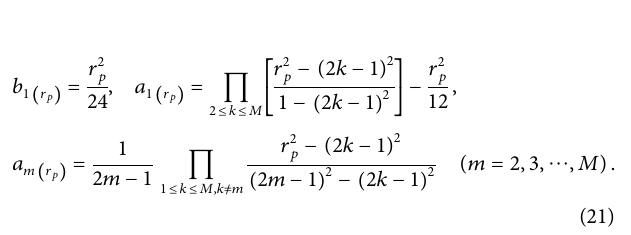
FIGURE 3 | Phase velocity dispersion curves of the acoustic staggered-grid FD schemes with r (cid:2) 0 . 3. (A – C) C-SFD ( M =2, 5, and 8); (D – F) M-SFD ( M =2, 5, and 8; N =1).